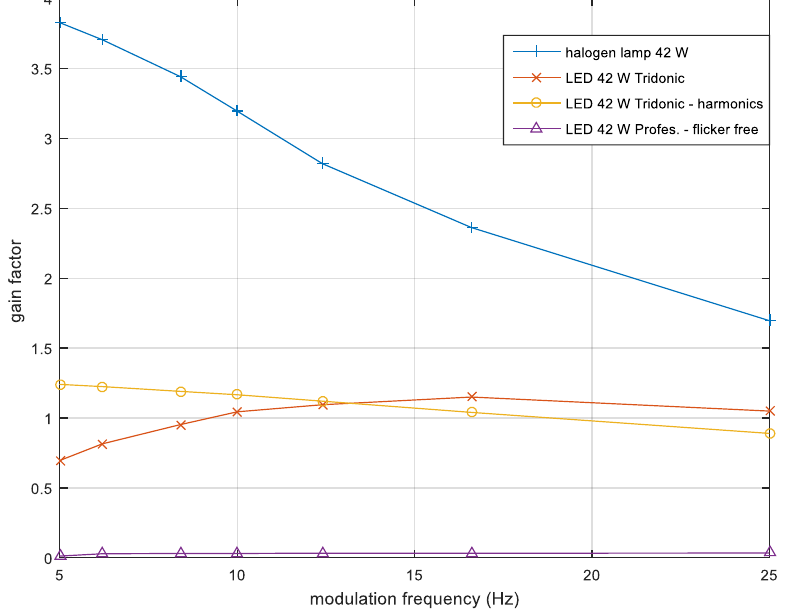
Figure 5. Gain factor curves for the halogen lamp 42 W and LED luminaire operating with a Tridonic 42 W driver, the same driver, but gf calculated with harmonic coefficient ratio and a flicker-free driver.